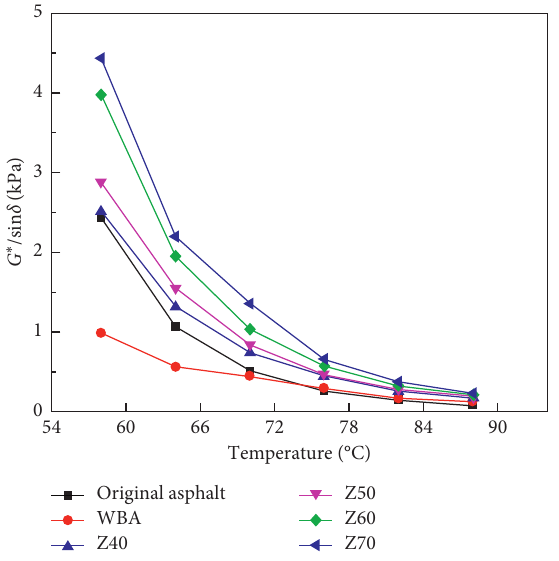
Figure 6: Test results of prior to RTFOT